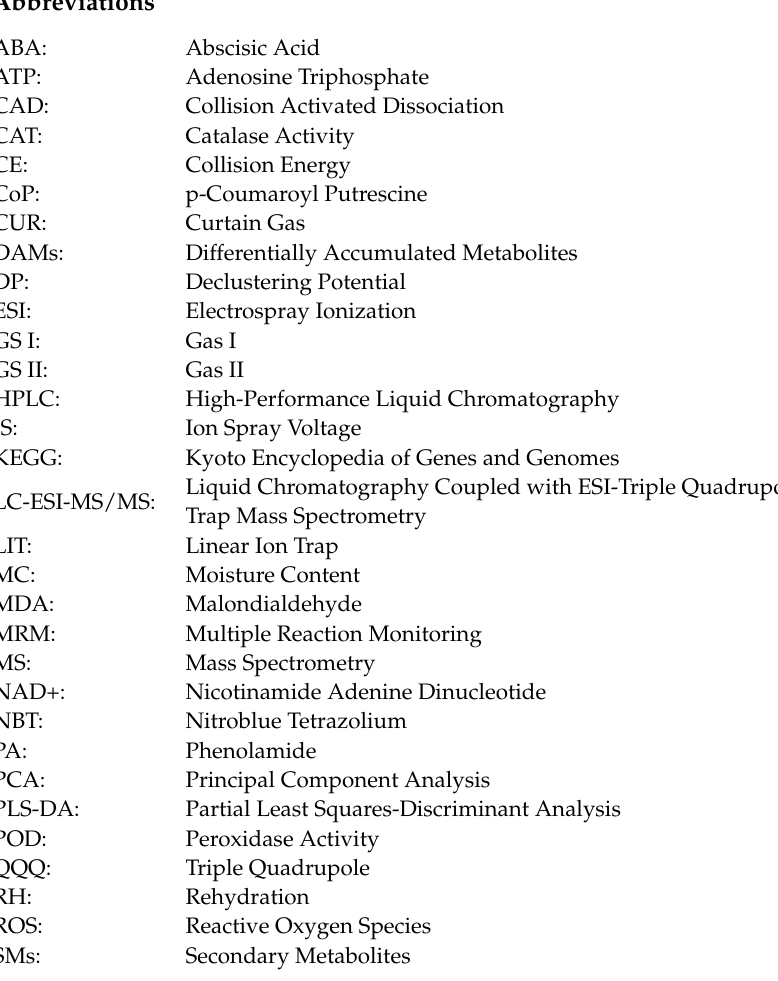
‘Qiuhong’. Table S2: Seven k-means cluster according to their expression pattern under the different treatments. Table S3: Comparison of upregulated and downregulated metabolites between normal conditions (CK and RH) and drought treatments (DA and